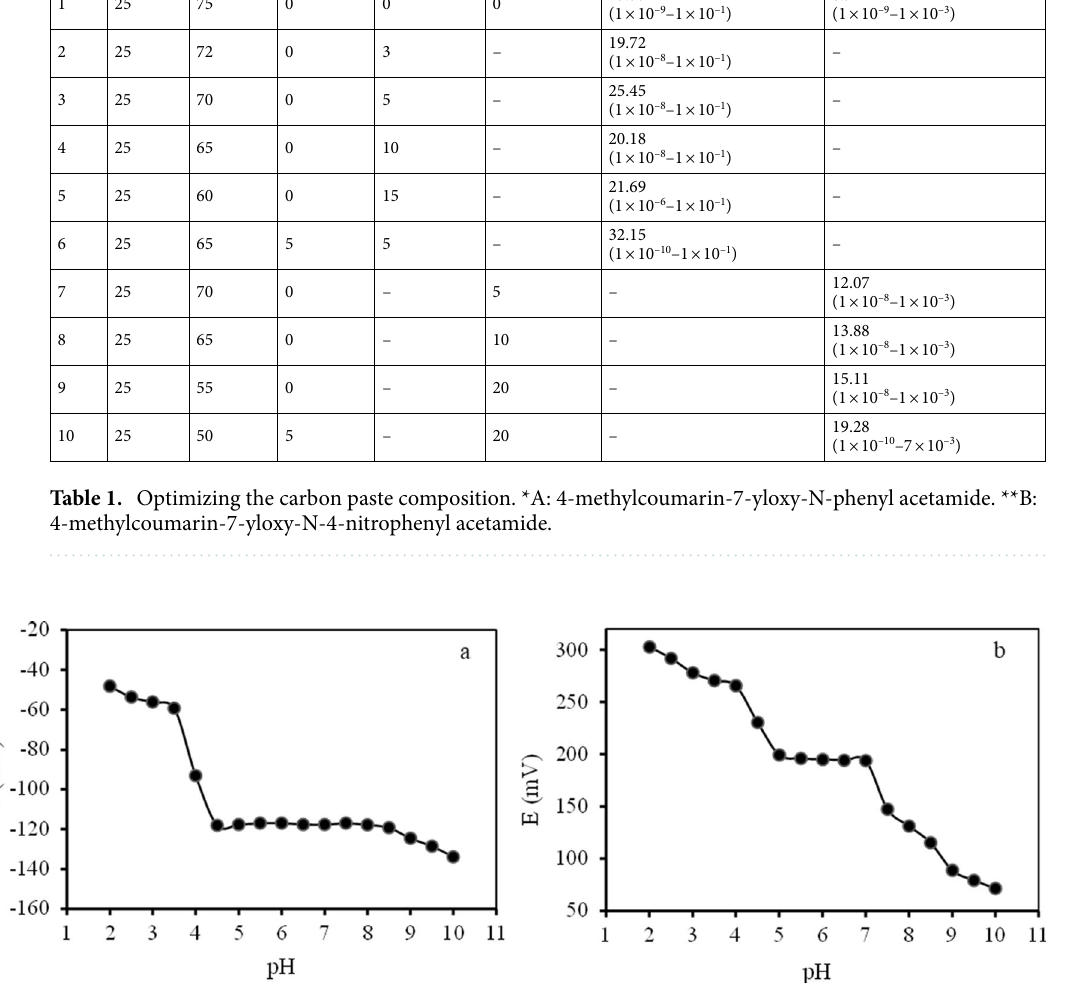
Figure 2. The effects of pH on the potential response of the ( a ) copper (II) selective CPE and ( b ) chromium (III) selective